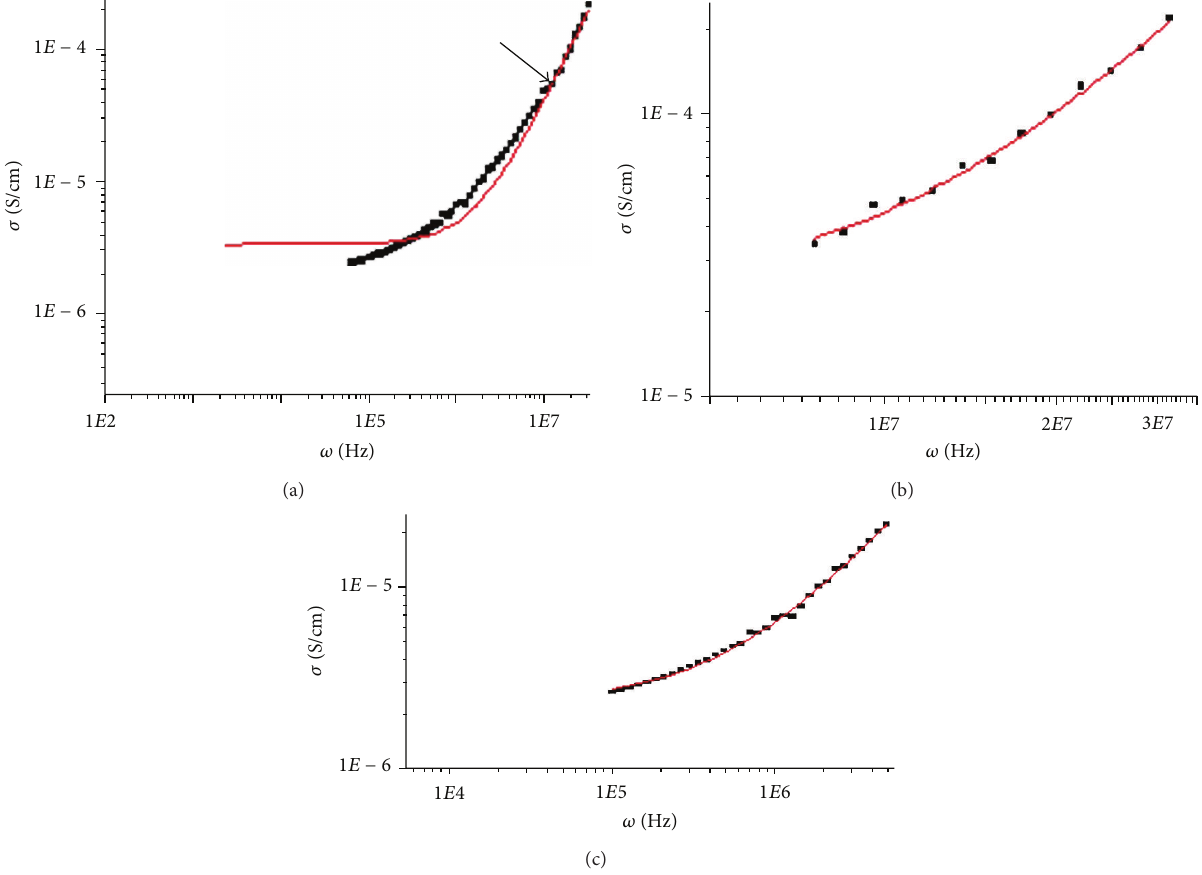
Figure 4: (a) A typical fitting curve for 𝜎 = 𝜎 0 + 𝐴𝜔 𝑛 along with the experimental points in complete frequency range. (b) Fitting for the same curve in the higher frequency range above the arrow marked in (a). (c) Fitting for the same curve in the lower frequency range below the arrow marked in